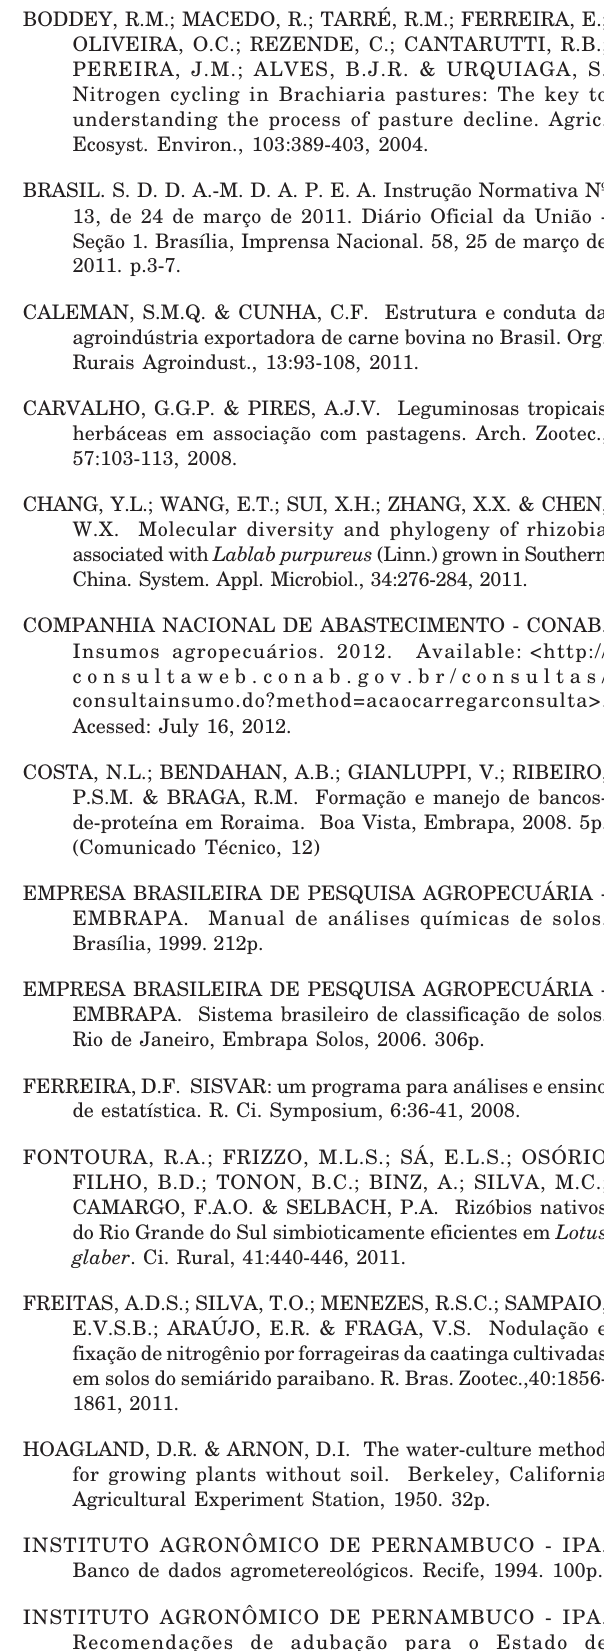
Table 4. Correlation coefficients between shoot (SDM), root (RDM) and nodule (NDM) dry matter, shoot N concentration (SNC) and total N (STN), relative efficiency (RE) and the N dose (ND)